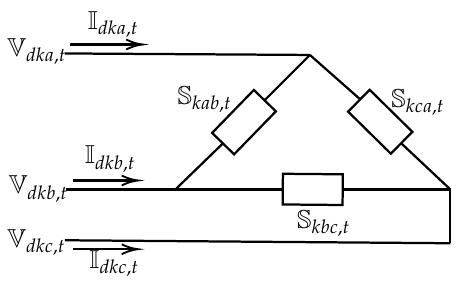
Figure 2. Three-phase load connected at node k in ∆